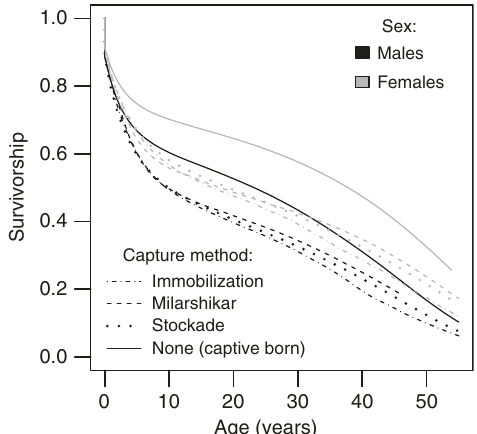
Fig. 4 Overall impact of capture and sex on elephant survival. The predicted survival curves for captive-born elephants compared to elephants captured from the wild by immobilization, stockade or milarshikar methods for males (black) and females (gray). Lines depict predictions from model averaging of all model fi ts presented in Table 1. In contrast to Figs. 1 and 2, here the predictions are adjusted by the age, sex, origin and birth cohort of each observation in the dataset and then averaged by sex and capture